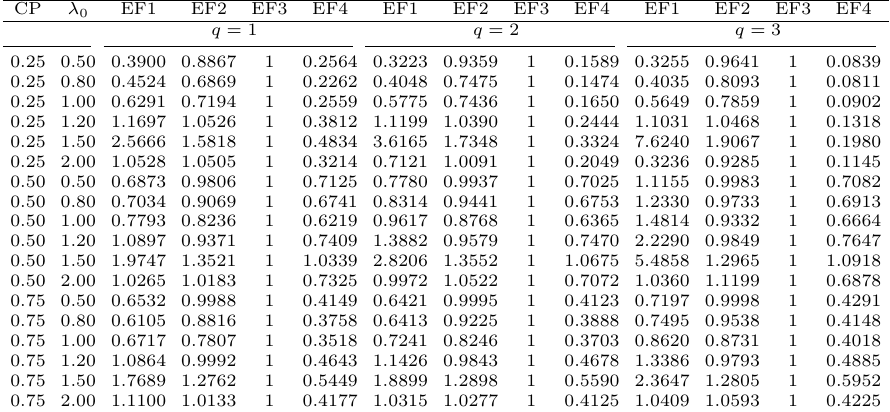
Relative efficiencies of the estimators of (cid:21) q (when (cid:21) = 1 : 5 ) under Type II